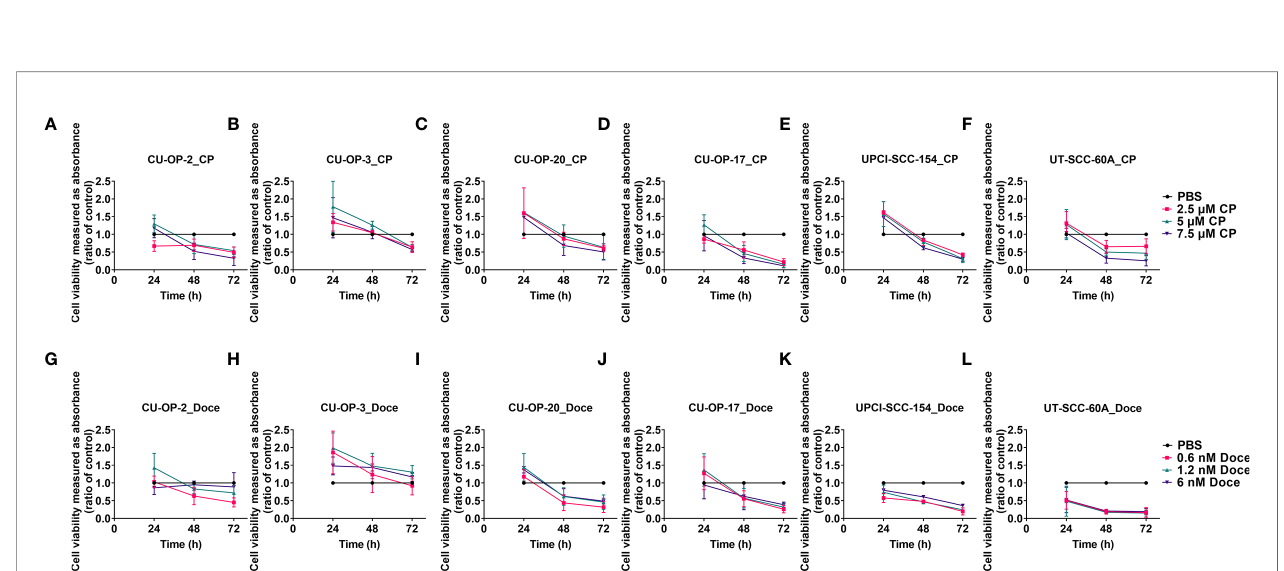
FIGURE 4 | WST-1 viability assays evaluating cellular metabolic capacity by absorbance on HPV + CU-OP-2, -3, -20, and UPCI-SCC-154 and HPV - CU-OP-17 and UT-SCC-60A cell lines upon treatment with cisplatin and docetaxel. WST-1 viability assays measuring absorbance following treatment for 24, 48 and 72 h of HPV + CU-OP-2, -3, -20 and UPCI-SCC-154 and HPV- CU-OP-17 and UT-SCC-60A with cisplatin (A – F) and docetaxel (G – L) resp. The graphs represent three experimental runs per cell line, and the data are presented with the mean ± standard deviation. CP denotes cisplatin and DOCE denotes docetaxel.